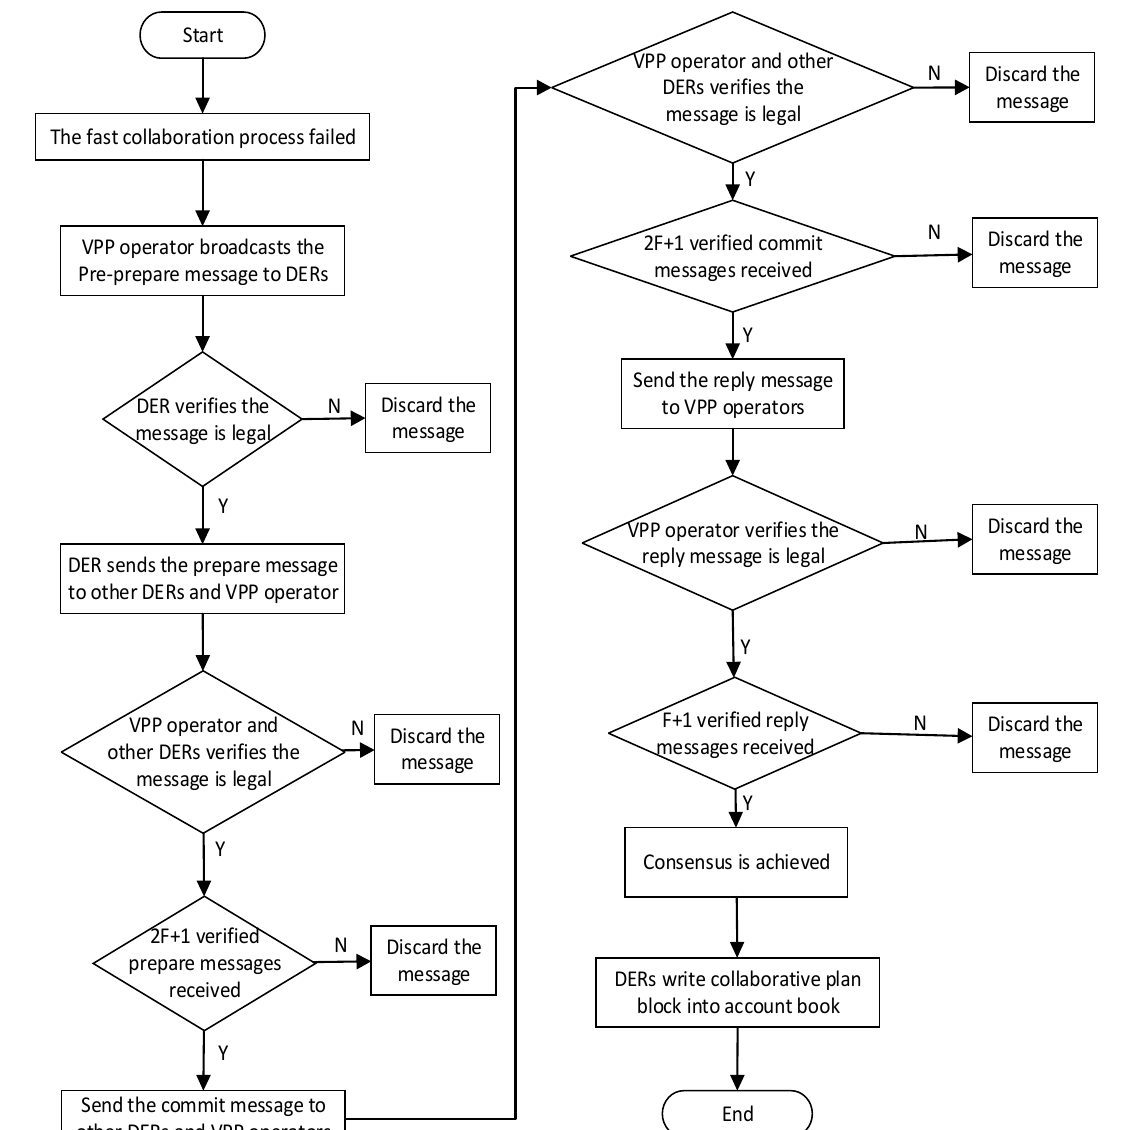
Figure 8. The flow chart of the PBFT consensus stage.